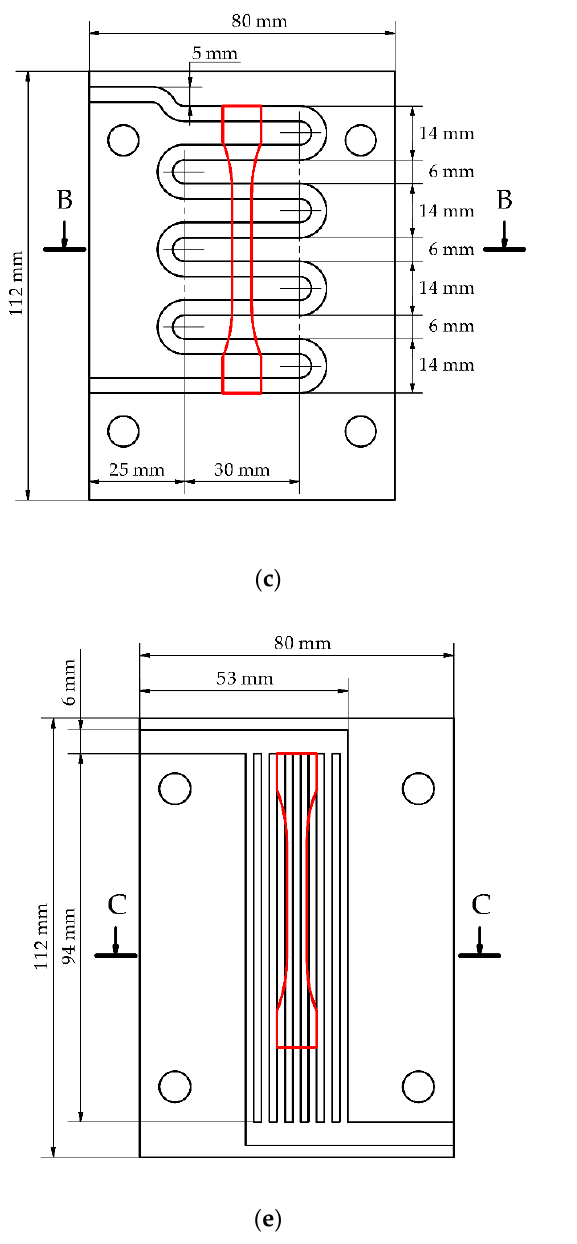
Figure 7. Variants of the wax injection mold geometry: ( a ) wax injection mold with rounded cooling channels, ( b ) cross-section of the rounded cooling channel, ( c ) wax injection mold with square cooling channels, ( d ) cross-section of the square cooling channel, ( e ) wax injection mold with finned cooling channels, ( f ) cross-section of the finned cooling channel. All dimensions in millimeters.